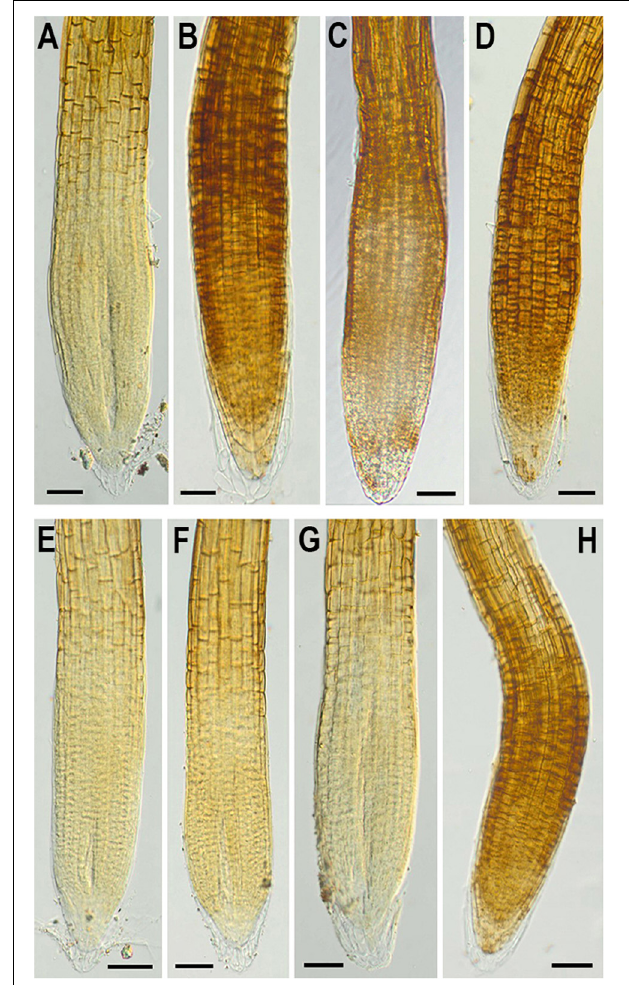
FIGURE 7 | In situ detection of O2 •− by nitroblue tetrazolium (NBT) staining in 6-day-old wild-type (A–D) and NMig1 -overexpressing (E–H) seedlings under optimal growth conditions (A,E) , and after exposure to heat shock (B,F) , drought (C,G) and high salinity (D,H) . Representative images from three independent experiments are shown. Scale bars = 50 µ m.